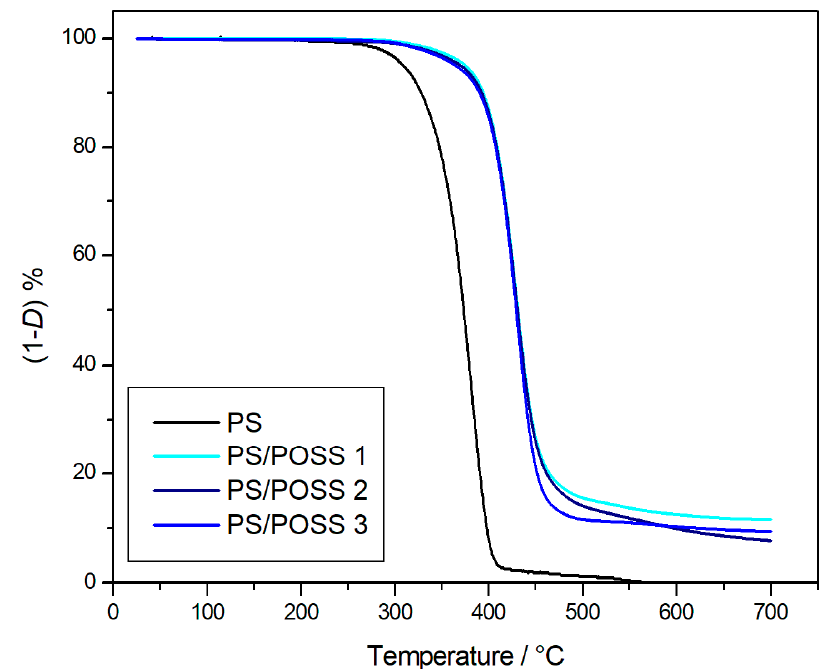
Polymers 2019 , x , x FOR PEER REVIEW Figure 4. Thermogravimetric curves, in an oxidative atmosphere, for PS and samples 1 , 2 and 3 .